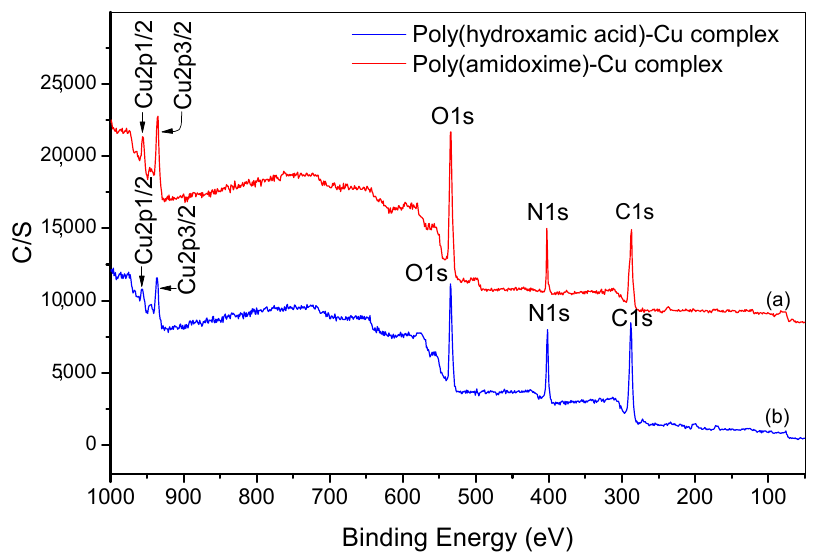
Figure 14. Wide scan of the X-ray photoelectron spectra (XPS) of jute cellulose-based PA ligand binding with copper ( a ) and jute-cellulose-based PHA ligand binding with copper based ( b ). The N 1s spectra of the core-level using PA ligand (Figure 14a) displayed two peaks with BEs of